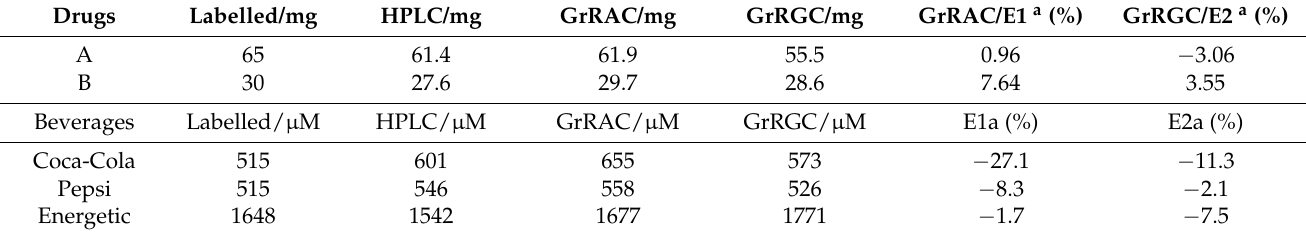
Table 3. Caffeine contents measured with cork-graphite